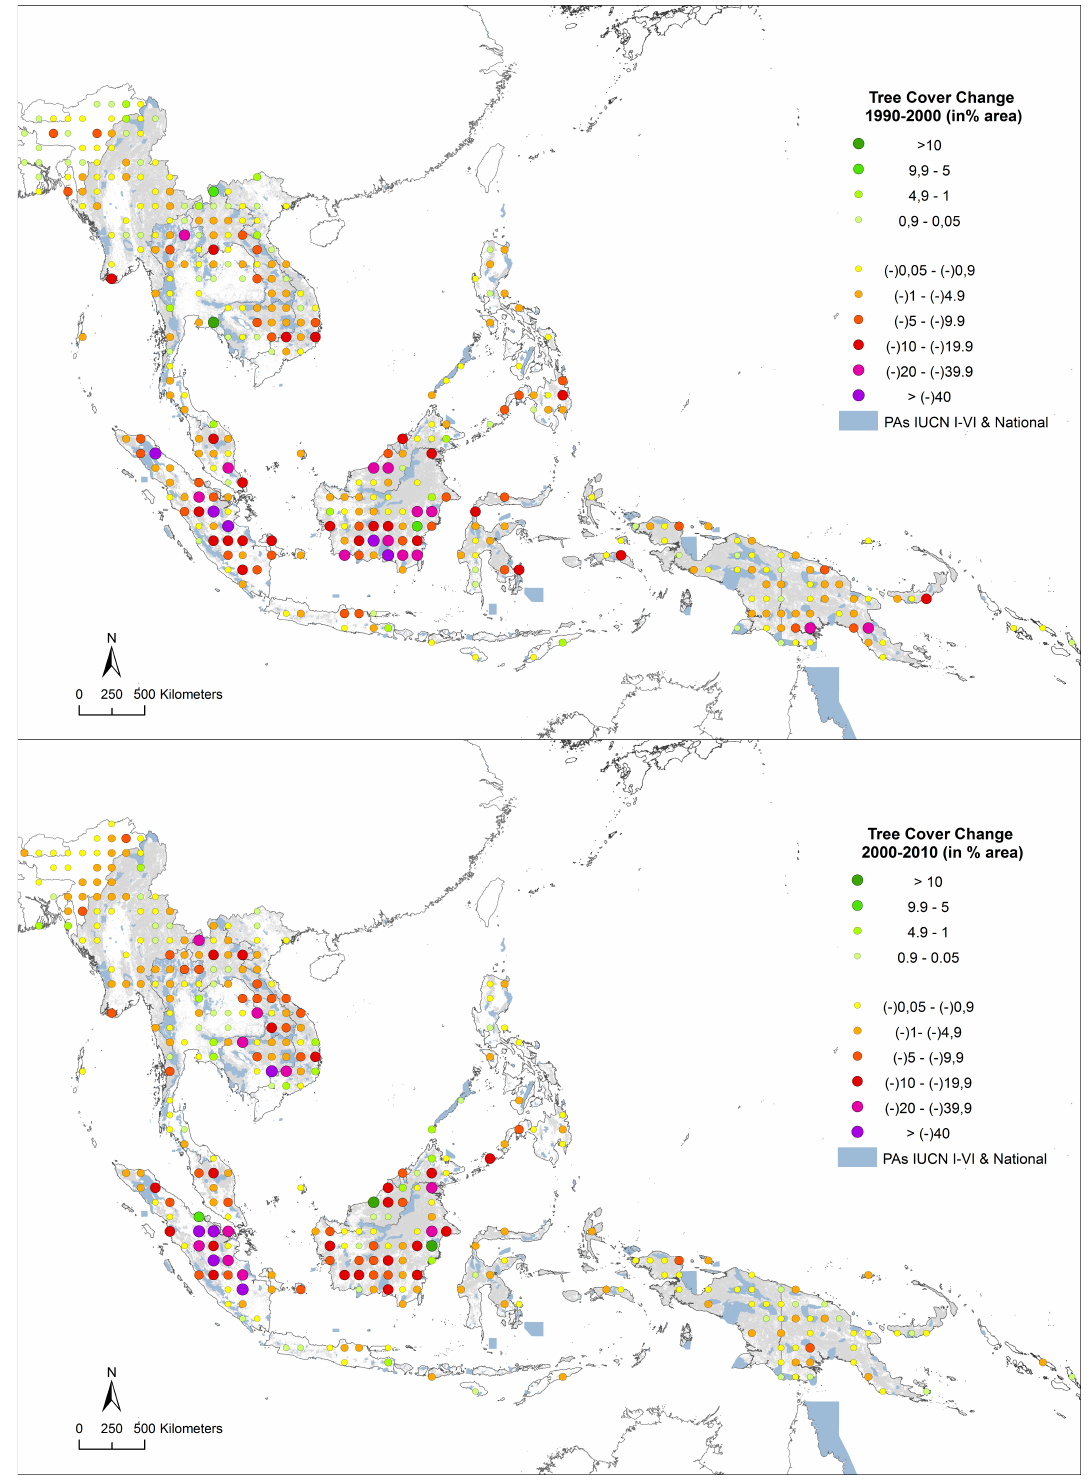
Fig. 3. Spatial distribution of forest cover change in Southeast Asia: change in forest cover per sample site (in % of land area, clouds excluded). IUCN I-VI and National Protected Areas from IUCN and UNEP (2009). Background map (grey): Forest Cover